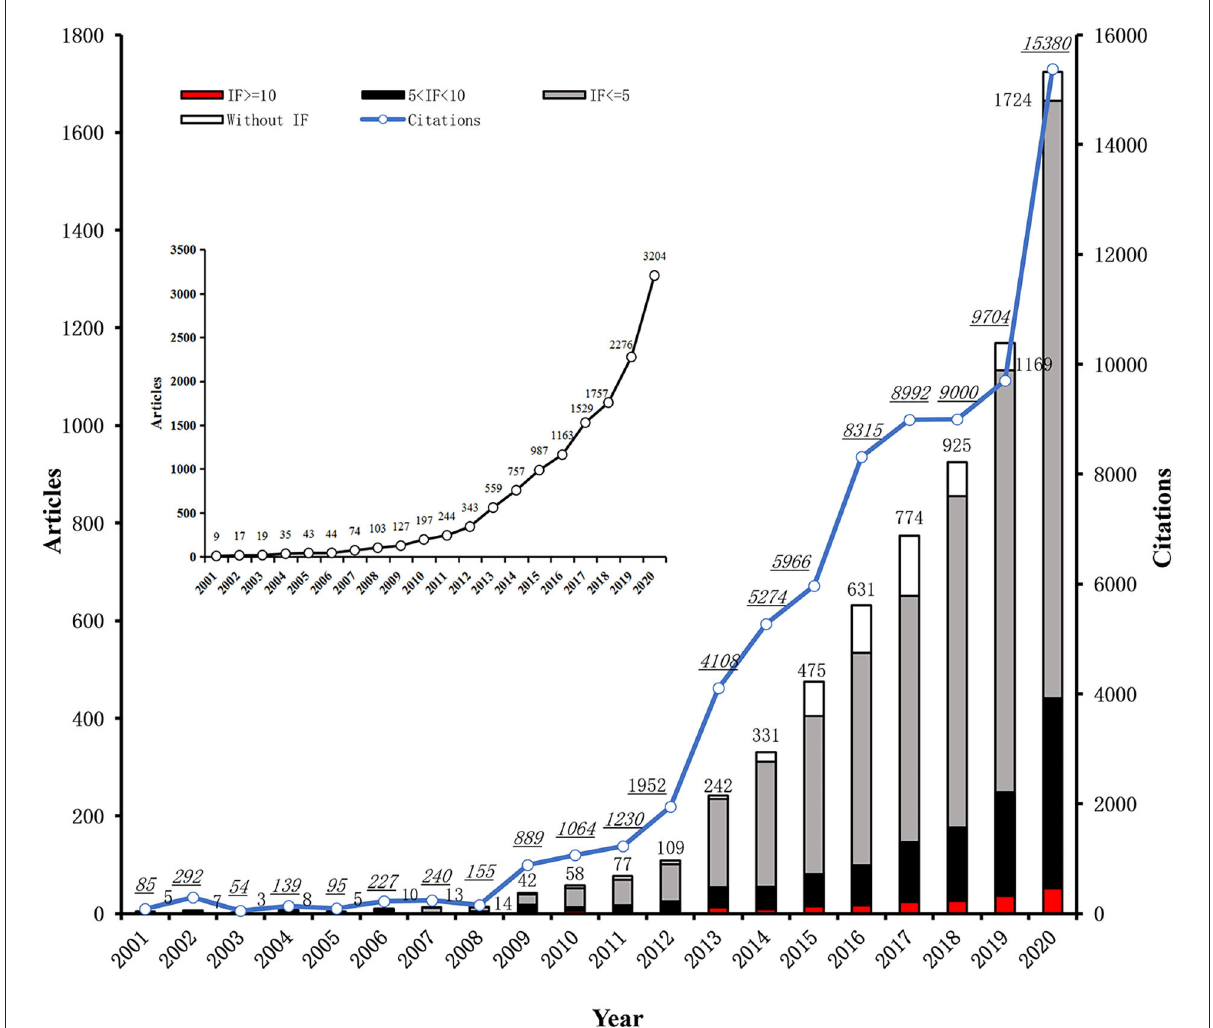
FIGURE1 Annual publications and the cumulative citations from 2001 to 2020.The X-axis represented each year from 2001 to 2020, the Y-axis represented the number of annual publications (bar) and the cumulative citations (blue line) to all articles till the year published by first and corresponding authors from affiliations of Critical Care Medicine (CCM) department or intensive care unit (ICU) in Chinese hospitals. These annual publications were stratified by the impact factor (IF) of the journals publishing these articles, marked on red (IF ≥ 10), black (5 < IF < 10), gray (IF ≤ 5)